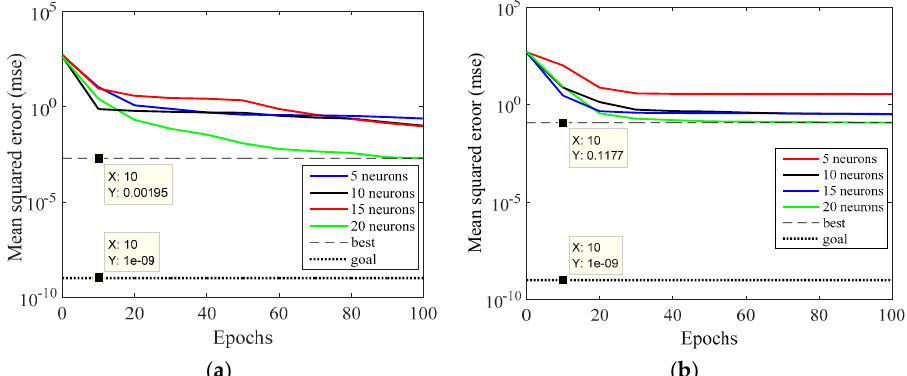
Figure 8. Performance of MSE of training, testing, and validation data for the NLOS environments for ( a ) 5, ( b ) 10, ( c ) 15, and ( d ) 20 neurons.